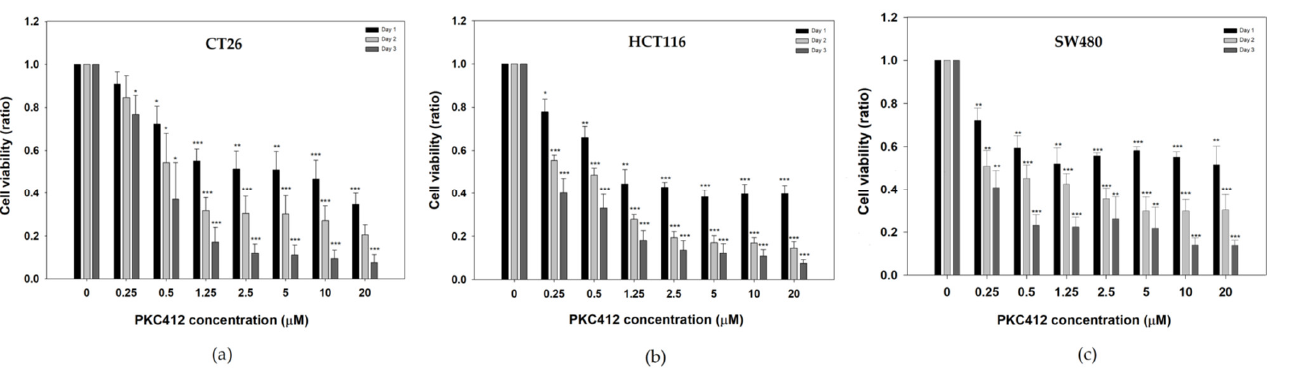
Figure 1. Cell viability of mouse and human colorectal adenocarcinoma after treatment with midostaurin. Mouse colorectal adenocarcinoma CT26 cells ( a ), human colorectal carcinoma HCT116 ( b ), and SW480 cells ( c ) were treated with different concentrations of midostaurin (PKC412) for 24, 48, and 72 h. Cell viability was measured by MTT reduction assay. Data from four separate experiments were expressed as mean ± standard error of the mean (SEM). Significant differences between control cells and cells treated with PKC412 are indicated by * p < 0.05, ** p < 0.01, and *** p < 0.001.